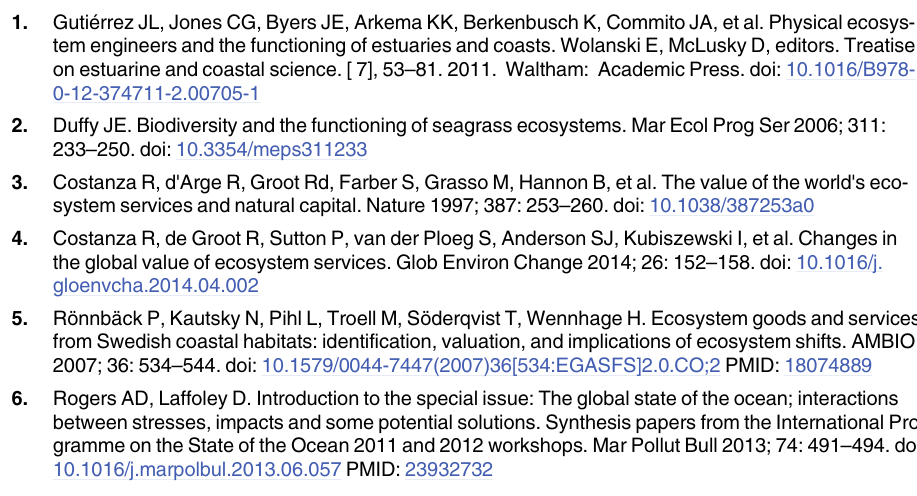
S2 Table. Abundance and biomass of fish in Dalby Bay (DB) and Kertinge Nor (KN) in Denmark, June 2011. Fish abundance and biomass was multiplied by 3.5 due to underestima- tion of the beach seine methods. Area estimates were based on one haul covering 250 m2. Ash- free dry weight (AFDW) were calculated from wet weight by conversion factors (see materials and methods). S3 Table. Stomach content analysis of fish species in Dalby Bay (DB) and Kertinge Nor (KN) in Denmark, June 2011. FO% = Frequency of occurrence in % of total number of stom- achs. # = mean abundance in stomachs containing the prey item ± SD. Size range of prey items pro- vided for G . aculeatus in Kertinge Nor. S4 Table. Proportion of faunal biomass assigned to trophic levels (TL), and sources for the